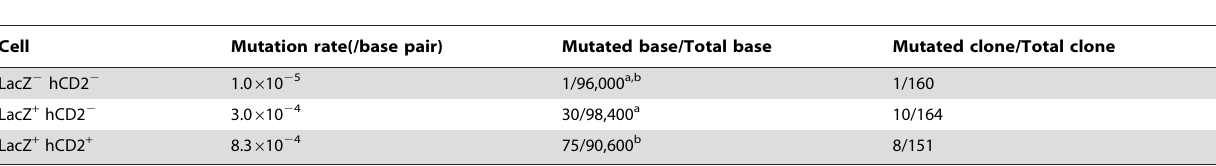
Cell Mutation rate(/base pair) Mutated base/Total base Mutated clone/Total clone